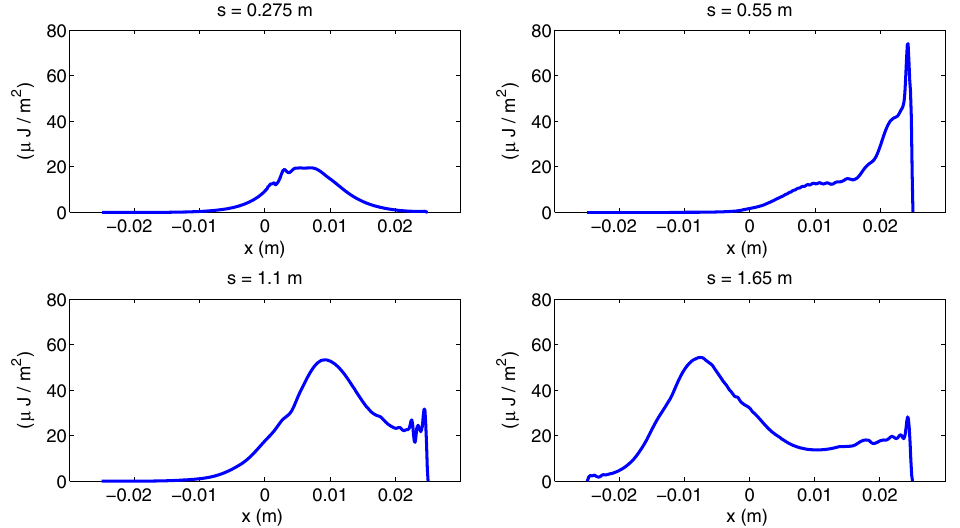
FIG. 18. Time-integrated energy flow to the upper horizontal surface, per unit area, as a function of x at various s .